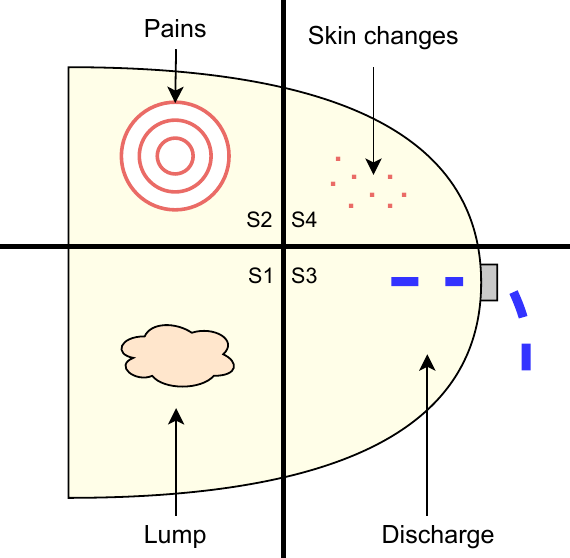
Figure 5. Schematic cross section of a breast showing the major stages of FBC ailment ( s 1, . . . , s 4). The SAC is modeled to sequentially compute and score the seriousness of the FBC symptoms (if any), during textual Q&A dialog with the